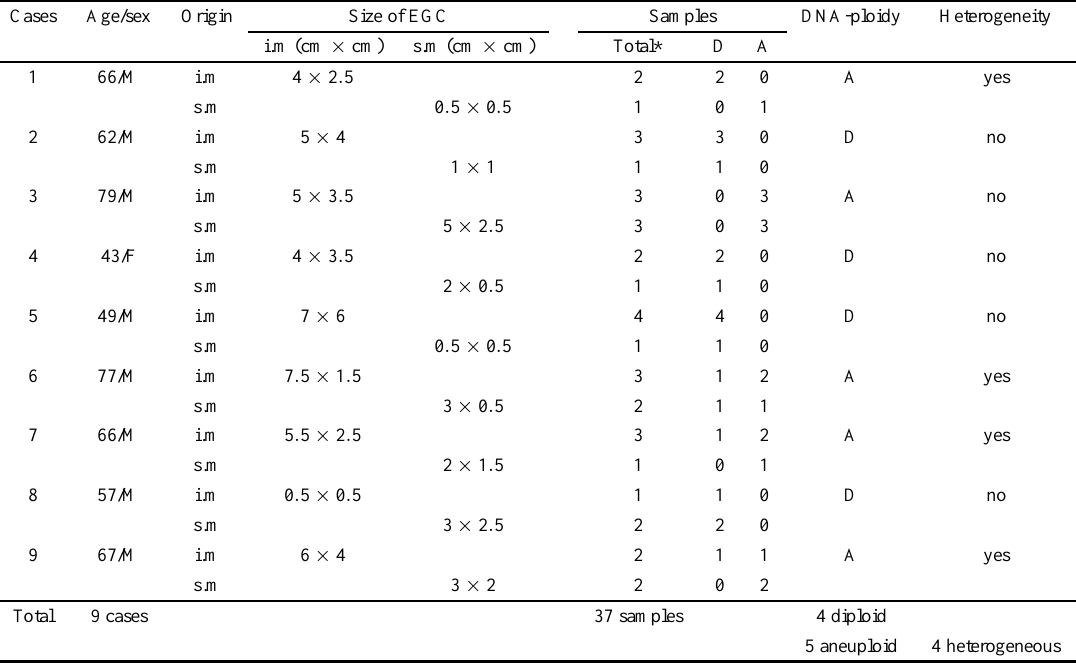
DNA-ploidy patterns in EGC infiltrating mucosa and submucosa Samples